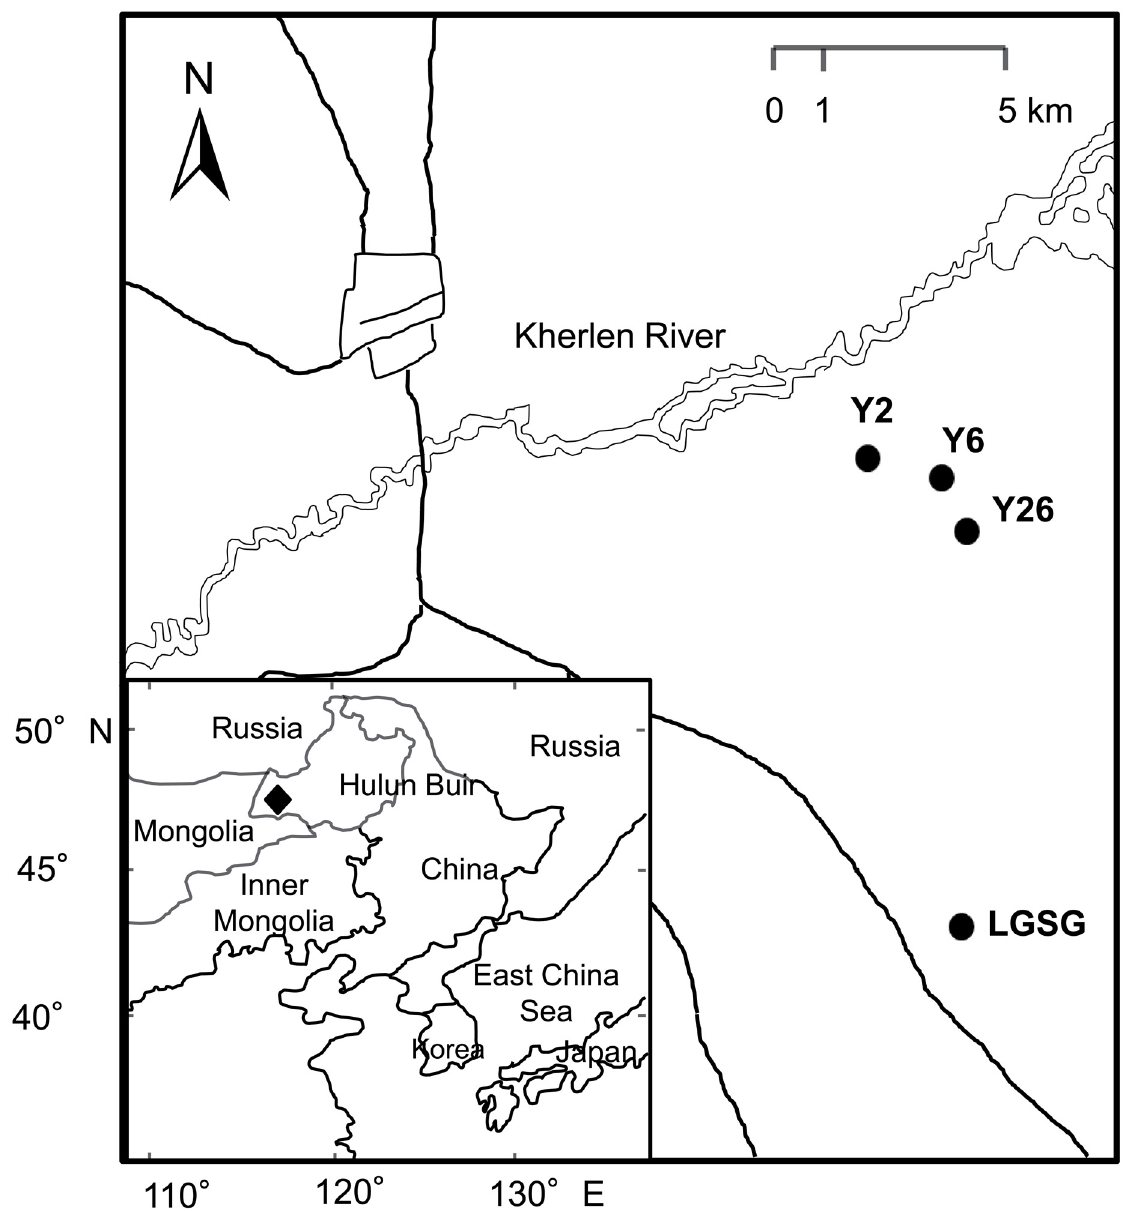
Fig 1. Study area ( ◆ ) and sediment sampling sites ( ● ) in the Hulun Buir grassland. Note: Reprinted from [12] under a CC BY license, with permission from Huhe, original copyright